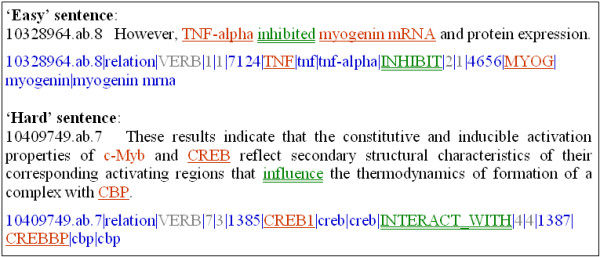
Examples of 'easy' and 'hard' sentences expressing a gene-gene semantic relation, and their SemGen output. Extracted arguments are shown in red, single underlined. Indicator and corresponding relation are shown in green, double underlined. SemGen output includes argument distances and indicator syntactic category, in gray.